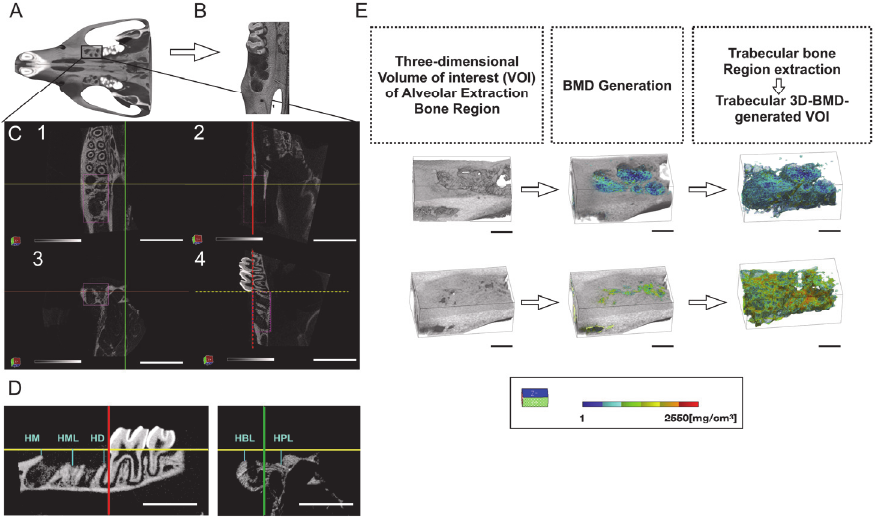
Figure 8. Assessment of 3D microcomputed tomography images of the maxillary extraction socket. Volume of interest (VOI) in the images of the extraction socket used for analysis is shown. ( A , B ) 3D microcomputed tomography scan of the extraction socket. ( C ) Reference plane: first, the mid-palatal suture plane of the maxillary left hemimaxilla in transverse view (C1, green line) was aligned, and then the hard palate referenced by the maxillary palatal plane of the sagittal view (C2, red line) and the coronal (C3, green line) planes were determined. The VOI was determined including the whole socket area by the border of the line of the M3 cement–enamel junction (C4, red dotted line) and the line of height of contour of M2 (C4, yellow dotted line). After the determination of VOI (C1-4), the VOI of the extraction socket was generated in a cuboidal volume (LX: 2.5 mm, LY: 2.2 mm, and LZ: 4.6 mm) (Scale bar = 4 mm). ( D ) Different aspects (left, parasagittal; right, frontal) of linear measurement of the buccal, middle, palatal, mesial, and distal enclosing the extraction socket area were evaluated as vertical height loss (scale bar = 1 mm). ( E ) Representative 3D images of the VOI of the extraction socket. Trabecular bone structures of the socket were extracted and reconstructed into a 3D image. After BMD generation, trabecular bone parameter measurements were conducted using the trabecular 3D-BMD-generated VOI. BMD value was reflected in the BMD color transition scale shown below (scale bar = 1 mm). Abbreviations: BMD, bone mineral density; HBL, buccal height loss of extraction socket; HD, distal height loss of extraction socket; HM, mesial height loss of extraction socket; HML, middle height loss of extraction socket; HPL, palatal height loss of extraction